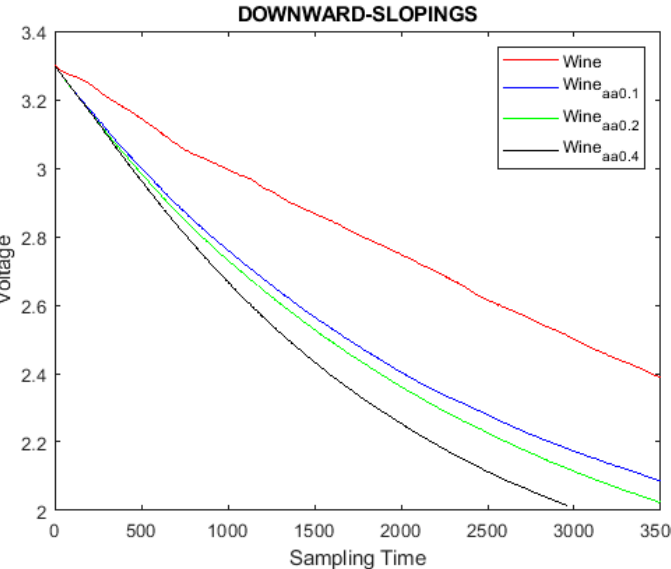
Figure 6. Details of upward slopes of wine with and without acetic acid ( top ); details of downward slopes of wine with and without acetic acid ( bottom ). The sampling time is measured in tenths of a seconds.